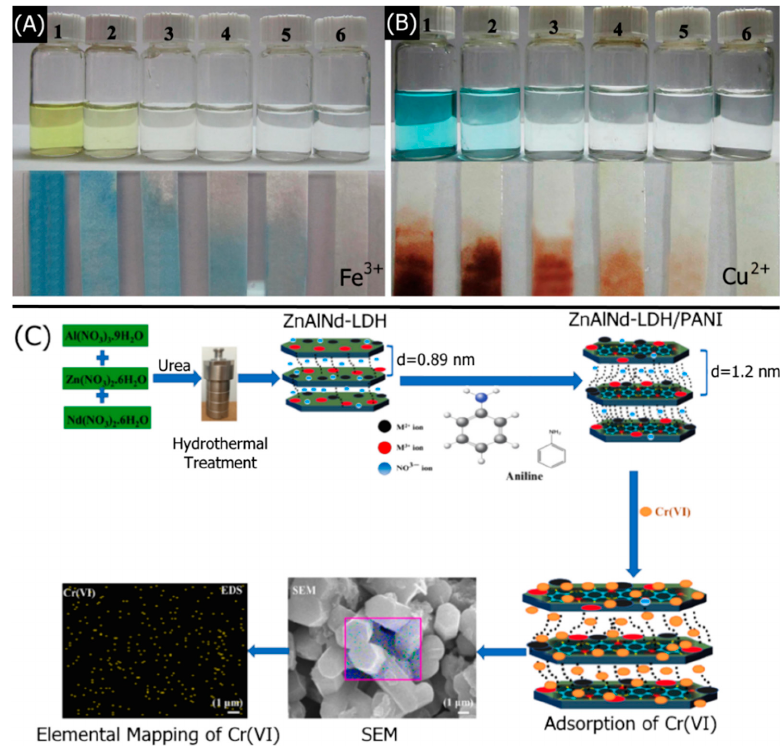
Figure 9. Color change of filter paper with MgAl–Fe(CN) 6 -LDHs when submerged in an ( A ) Fe 3+ and ( B ) Cu 2+ solution at different concentrations: 0.1 M, 0.01 M, 1 mM, 0.1 mM, 0.01 mM, and 1 nM for vials 1–6, respectively, reproduced from reference [145]; with permission from Elsevier B.V., 2016 ( C ) schematic illustrating the synthesis of the ZnAlNd-LDH/PANI nanocomposite and its adsorption of Cr 6+ . The SEM micrograph of the LDH/PANI and the elemental mapping of the adsorbed Cr 6+ are also shown, reproduced from reference [146] with permission from Elsevier B.V., 2021.